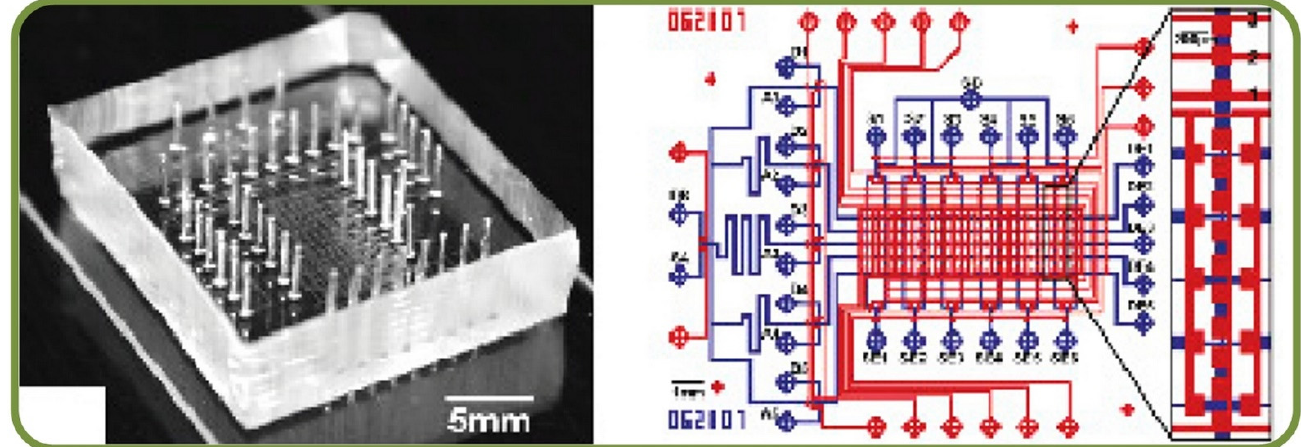
Figure 11. The internally calibrated quantification of protein analytes by fluorescence immunoassays in a disposable elastomeric microfluidic chip [206].